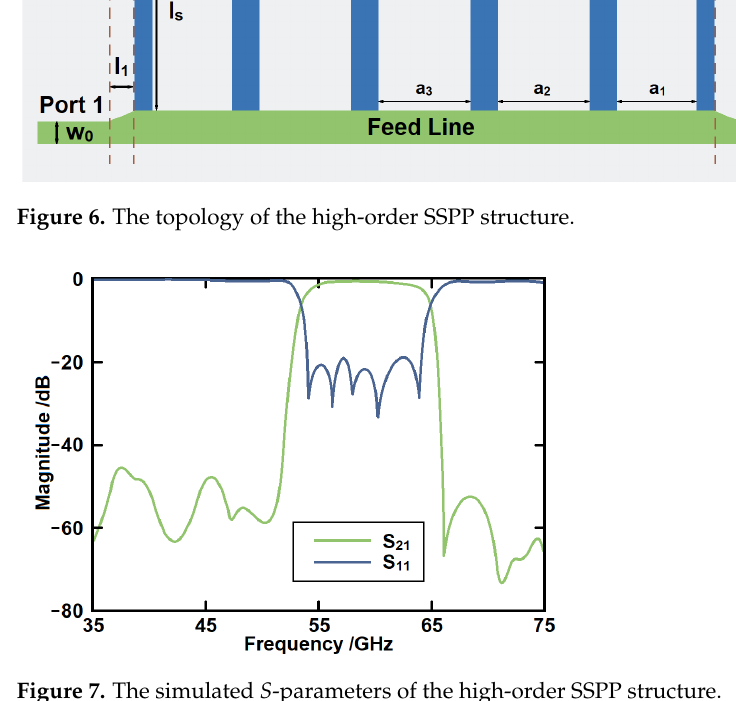
Figure 8. The field distribution of the SSPP structure at ( a ) passband and ( b ) stopband. The filtering properties are produced by the tabs of the SSPP structure. At the passband, the condition of resonance is not satisfied; therefore, all the tabs can be regarded as open-ended lines. Then, the electromagnetic energy can pass through the feed line without much attenuation. However, at the stopband, the tabs start to resonate, and, based on the quarter-wave impedance transformation theory, the tabs now become short-ended lines. In this condition, the electromagnetic waves can be regarded as seeing a barrier and are reflected back to the feeding port. The tabs of SSPP act as switches with different states at different frequencies. From stopband to passband, the first cut-off frequency can be calculated as